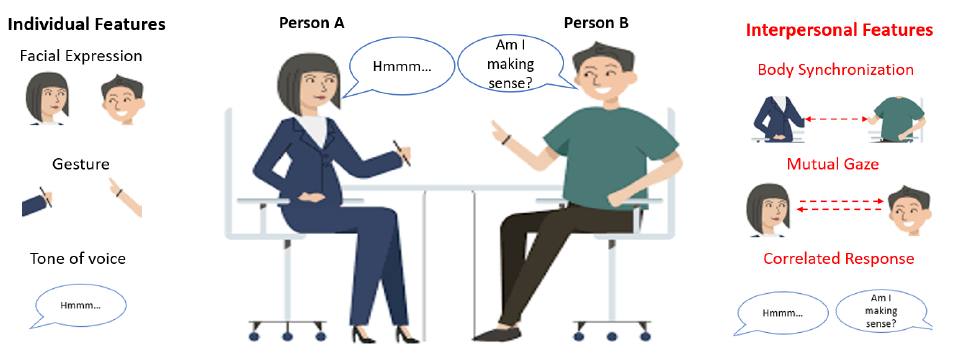
Figure 1. Interpersonal and individual features help humans recognize